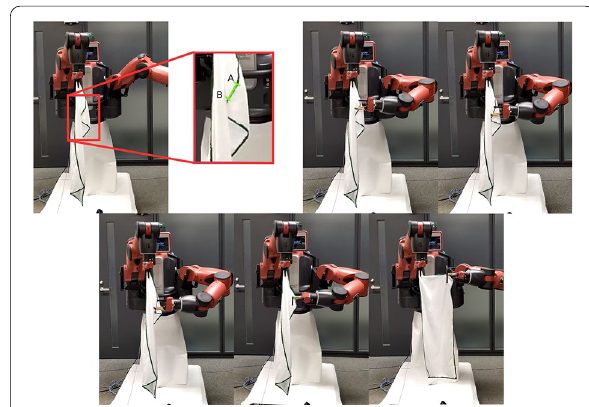
Fig. 13 Sequence of the robot unfolding a hidden corner folded forwards. By moving the robot’s gripper through a trajectory defined by the physical edge (the points from A to B) we can reveal the hidden corner